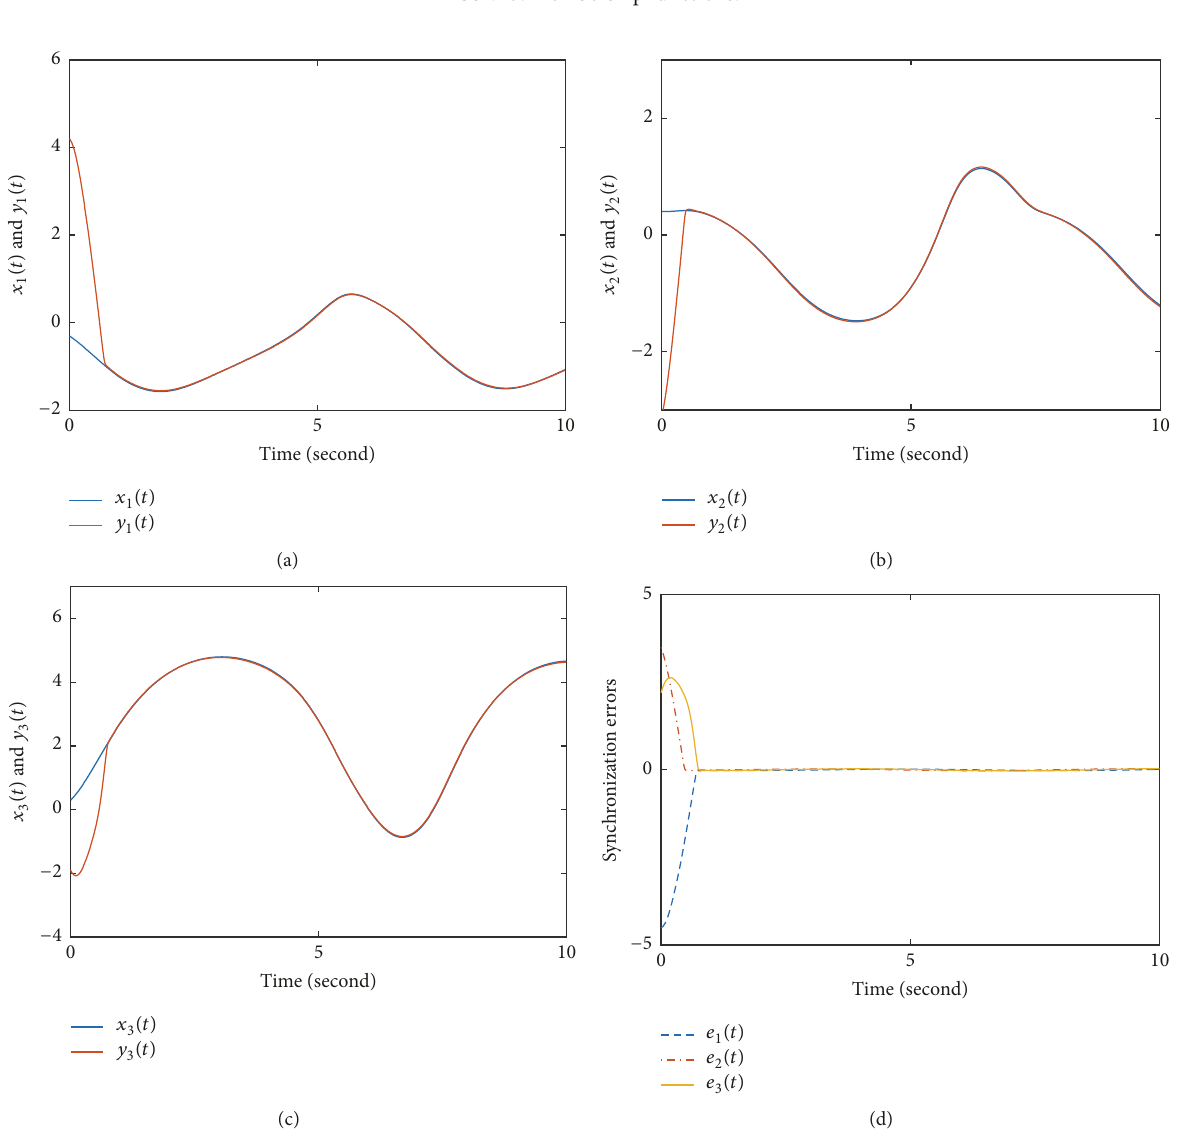
Figure 3: Membership functions.